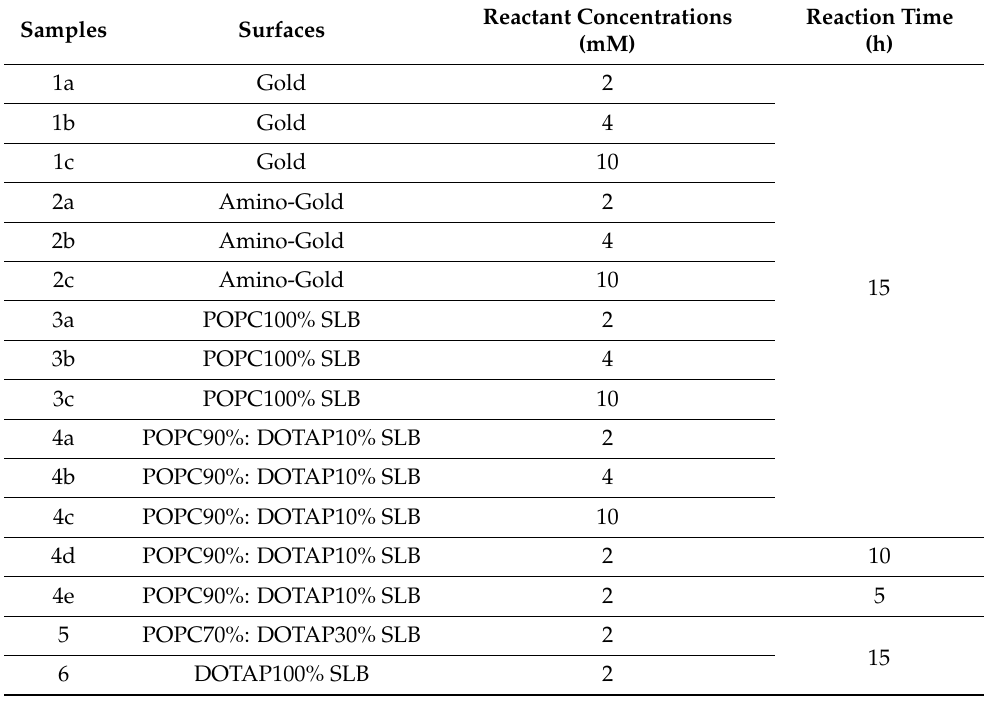
Table 1. Experimental conditions of PB growth on different surfaces. Samples